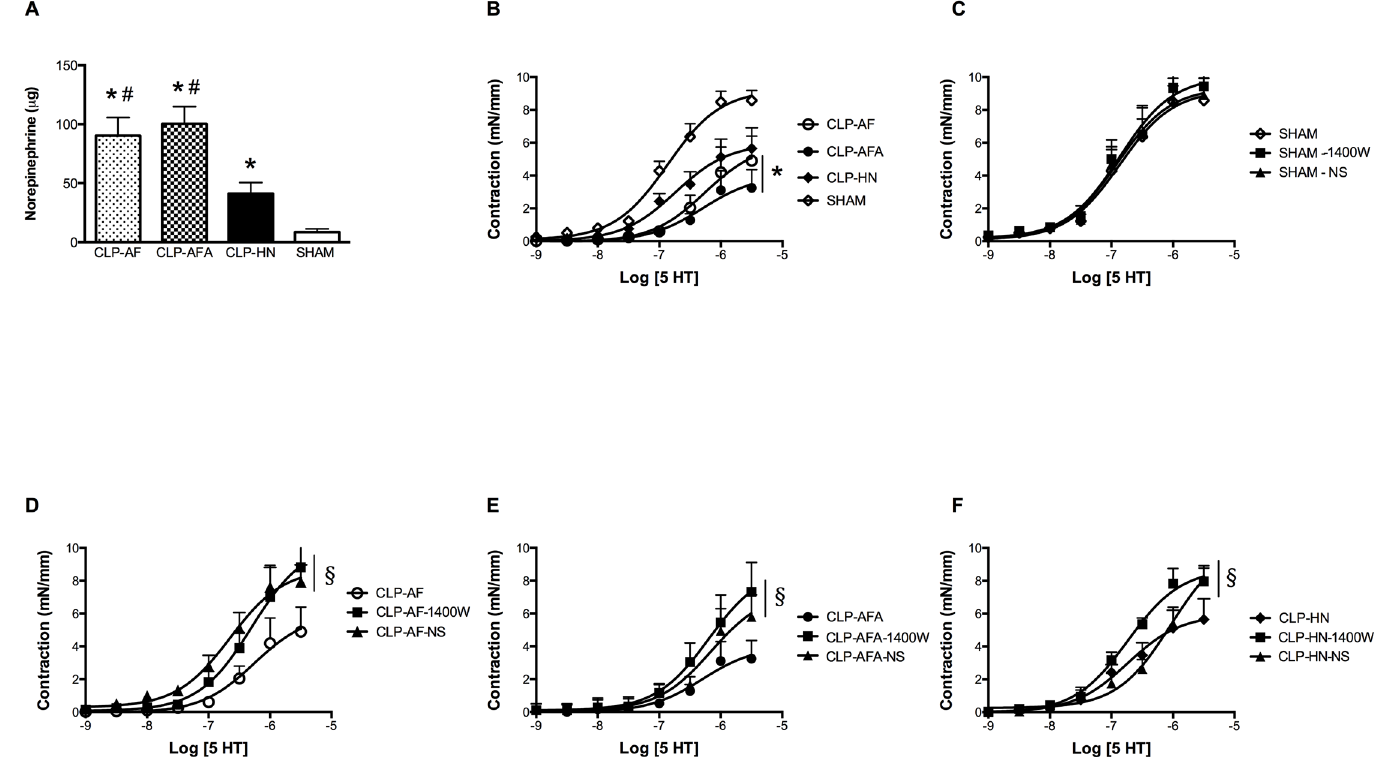
Fig 3. (A-F): A) Cumulative norepinephrine dose needed to reach the mean arterial pressure (MAP) objective in SHAM and septic rats treated with different enteral nutrition formulations: Peptamen 1 AF (AF), Peptamen 1 HN (HN), Peptamen 1 AF enriched with arginine (AFA); * p < 0.05 vs . SHAM rats, # p < 0.05 vs . CLP-HN rats. n = 5 for SHAM group and n = 12 for CLP-HN, CLP-AF and CLP-AFA groups. B) Ex-vivo vascular contractility of mesenteric resistance arteries of SHAM and septic rats in response to 5-HT, * p < 0.05 vs . SHAM rats. n = 5 for SHAM group and n = 12 for CLP-HN, CLP-AF and CLP-AFA groups. C-F) Effect of the specific iNOS inhibitor (1400W) and the specific COX-2 inhibitor (NS-398) on 5-HT- dependent contraction in mesenteric resistance arteries in each different group of rats (C = SHAM rats, D = CLP-AF rats, E = CLP-AFA rats, F = CLP-HN rats). § p < 0.05 vs. without inhibitor. Results are expressed as mean ± SD. n = 5 for SHAM group and n = 12 for CLP-HN, CLP-AF and CLP-AFA